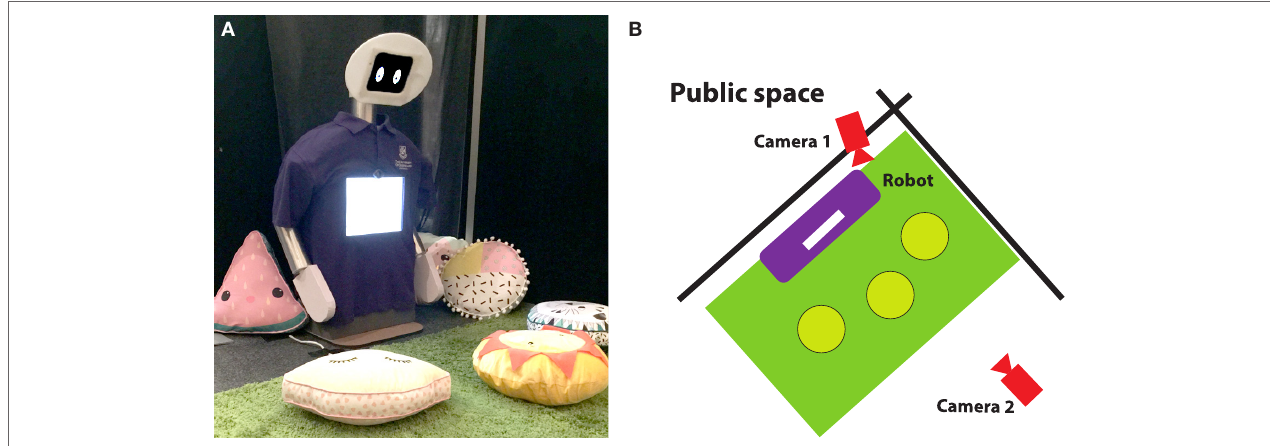
FigUre 1 | The experimental setup. (a) Opie in the experimental setup—Opie is set up to create a safe space in front of the robot with a mat and cushions. The angle of the robot’s head helps to shape the space in front of Opie. Opie is constructed from foam and pool noodles, which provides a soft exterior and allows children to interact with Opie through touch. The height of the robot is short to allow interactions with children that are sitting on the cushions. (B) Opie’s position in the space with the location of the cameras and cushions (where the children sit)